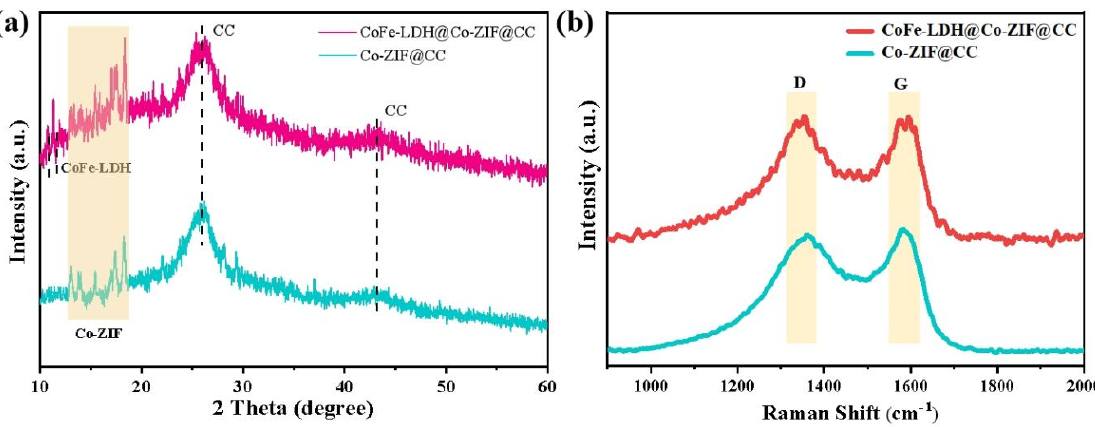
Figure 3. Structural characterization for CoFe-LDH@Co-ZIF@CC and Co-ZIF@CC: ( a ) XRD pattern, ( b ) Raman